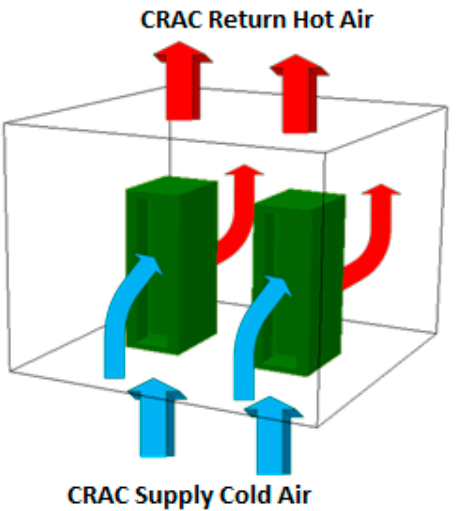
Figure 6. Arrangement of virtual server room in case of 2 racks.